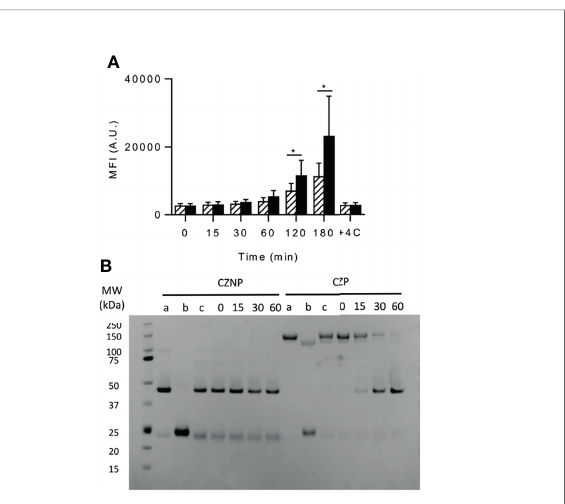
FIGURE 2 | Mapping of T-cell epitopes of certolizumab pegol (CZP) and non- pegylated certolizumab (CZNP). T-cell lines generated from cells from PBMCs collected from 12 healthy donors and reacting with the peptide pools ( Figure S3 ), were tested by Elispot with individual peptides (10µg/ml) (black bars) and without peptide (open bars). Only T cell lines reacting positively in the two independent Elispot assays were presented. T-cell lines were raised against (A) CZNP (B) CZP. (C) Summary of the mapping. Bold: Mutations with respect germline sequences. boxed residues: amino acids of CDR regions.